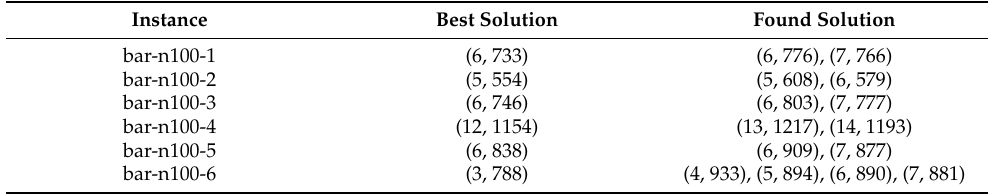
Table A2. Results on Sulzbach Sartori and Buriol’s